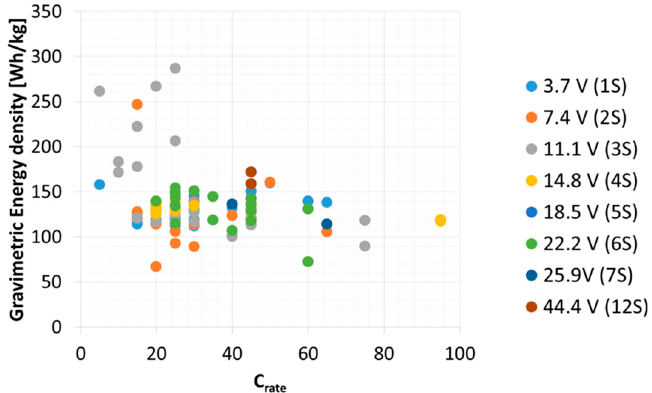
Figure 3. Gravimetric energy density of commercial Lithium-polymer batteries as a function of the battery maximum discharge rate ( C rate